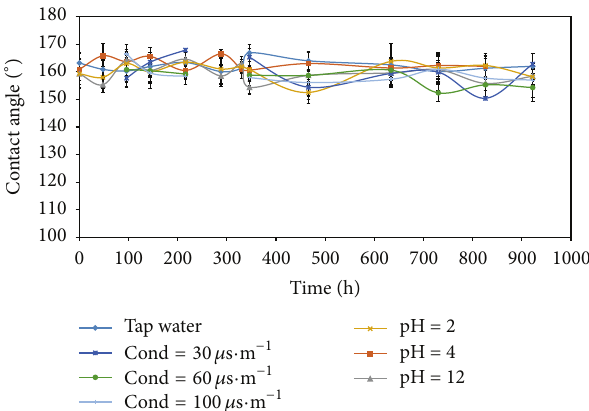
Figure 3: Variation in the static contact angle as a function of immersion time in different solutions.